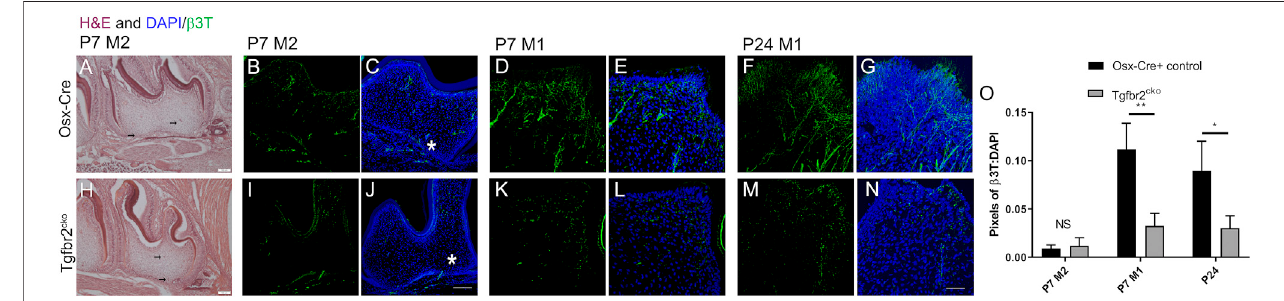
FIGURE 2 | DP innervation is reduced in developing Tgfbr2 cko molars. Innervation did not appear signi fi cantly disrupted during early postnatal tooth development. Representative images of H&E-stained mandibular M2s at P7 (A – H) with two black arrows in each image indicating hypothesized neuronal structures. Scale bar = 100 μ m. N = 3 for control Osterix-Cre and 4 Tgfbr2 cko samples. (B – G, I – N) Z-stacks (10 μ m thick) of β 3T-positive structures were collected and presented in maximum projectionmodetodemonstratetotalafferentinnervation. (B – C,I – J) Confocalimagesofcontrol (B – C) and Tgfbr2 cko (I – J) M2DPdemonstratedafferentstructures